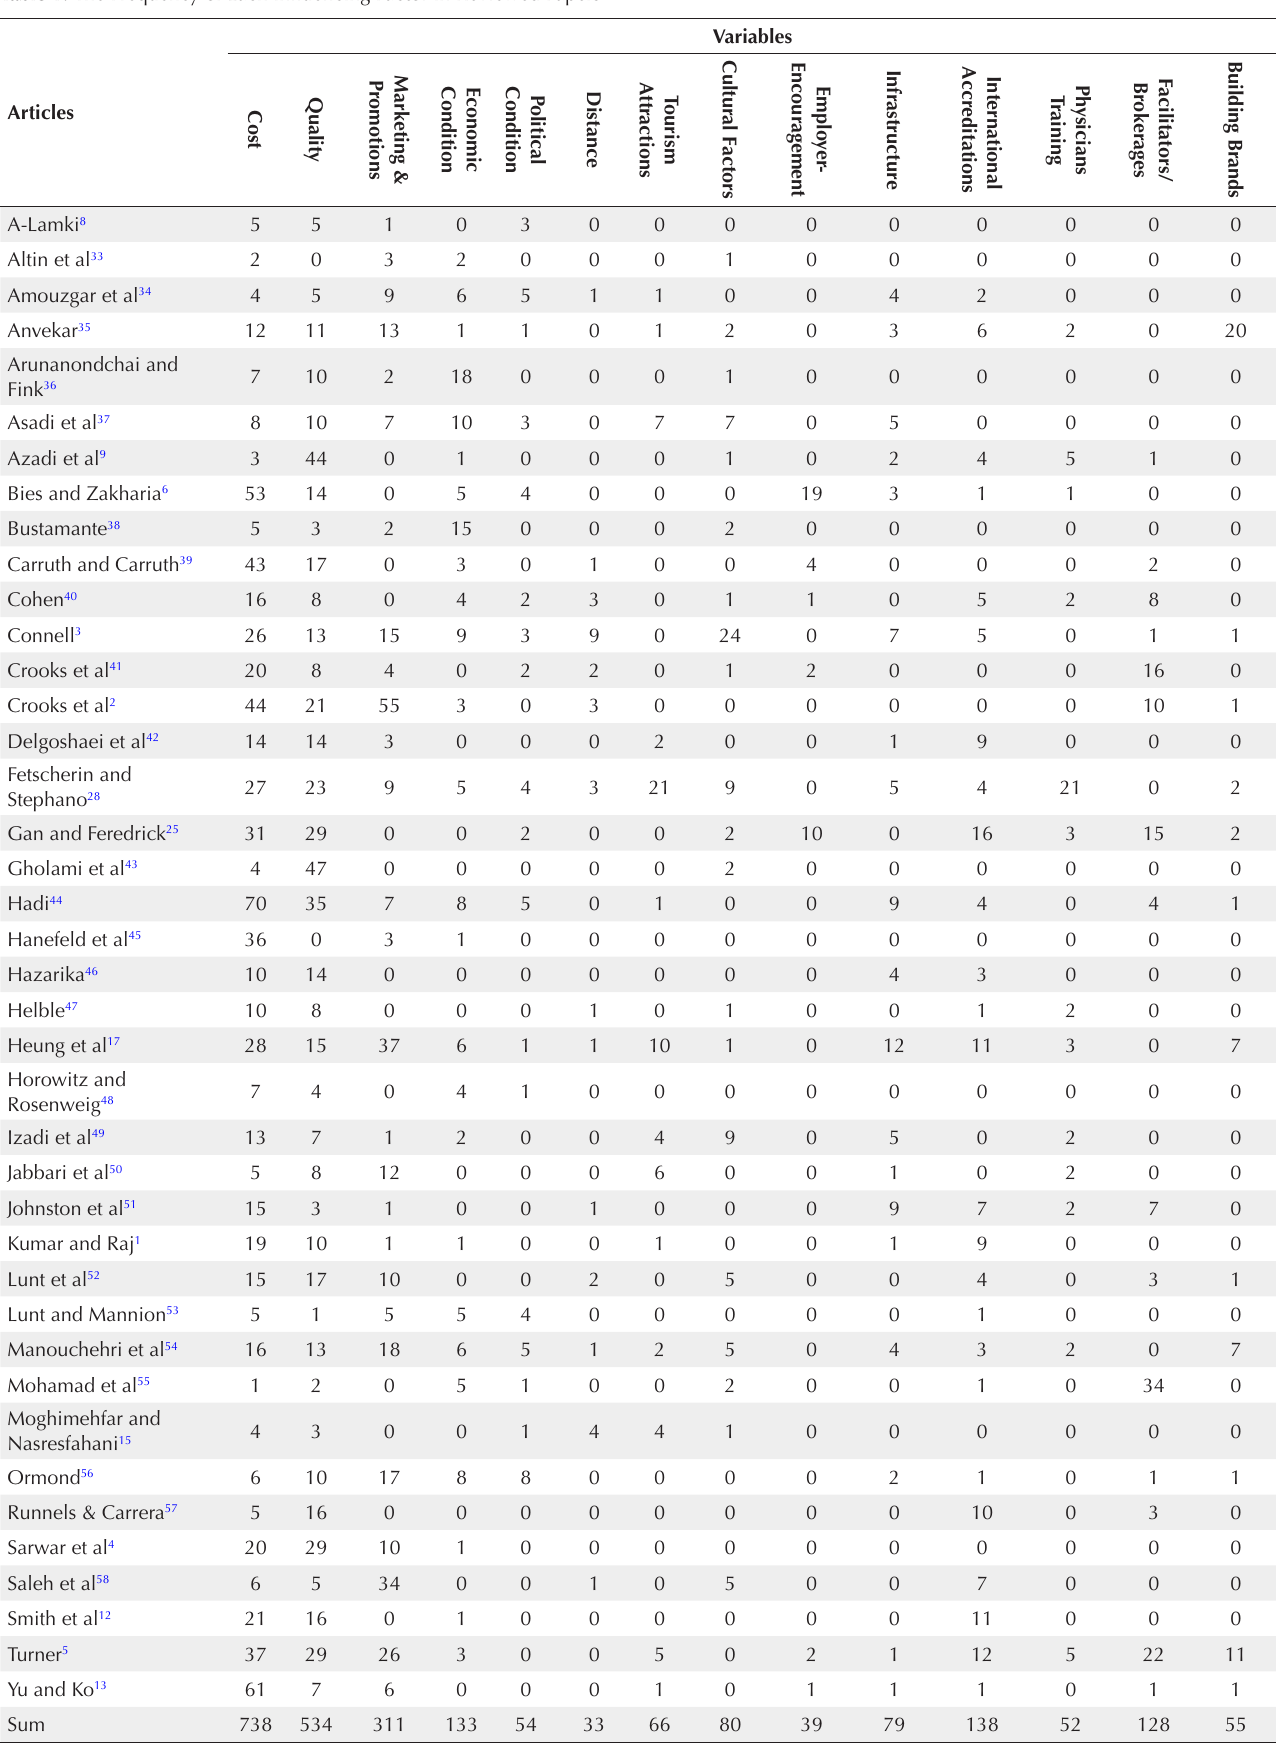
Table 1. The Frequency of Each Influencing Factor in Reviewed